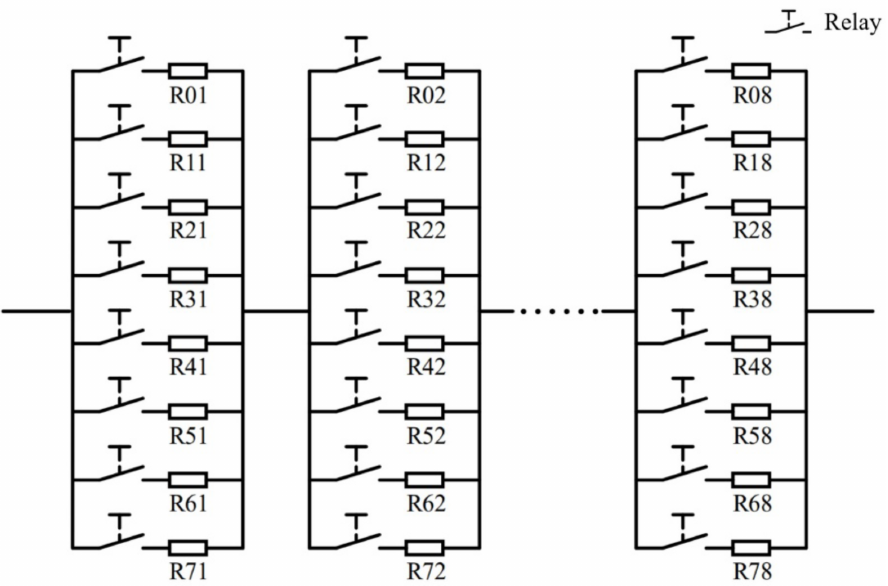
Figure 2. Schematic diagram of the resistance synthesis using the Octal decomposition principle. Only one relay in each column is allowed to be closed at one time, and the synthesized resistance is the summation of the eight resistors from the eight corresponding columns. The resistance values in the j th column should satisfy R ij = i · 8 j − 1 ( i = 0, . . . . . . , 7 ) . The calculated resistance values are presented in Table